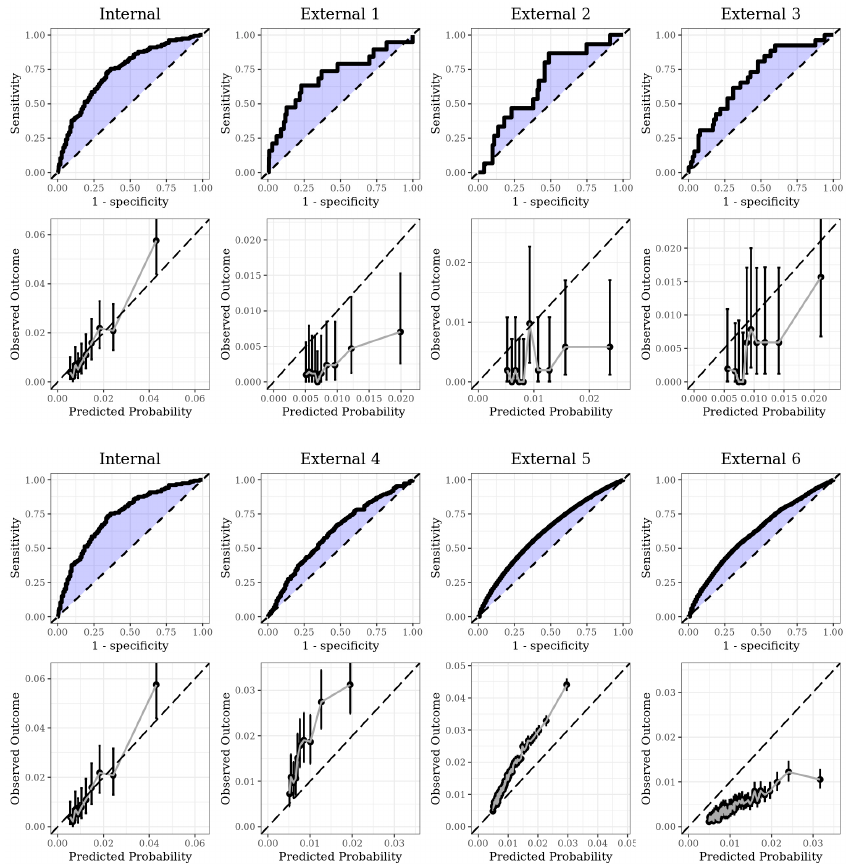
Figure 2. The area under receiver operating characteristic (AUROC) plot showing the performance of the L 1 regularized logistic regression model and calibration plot comparing predicted probability calculated by the prediction model with the fraction of observed outcome.